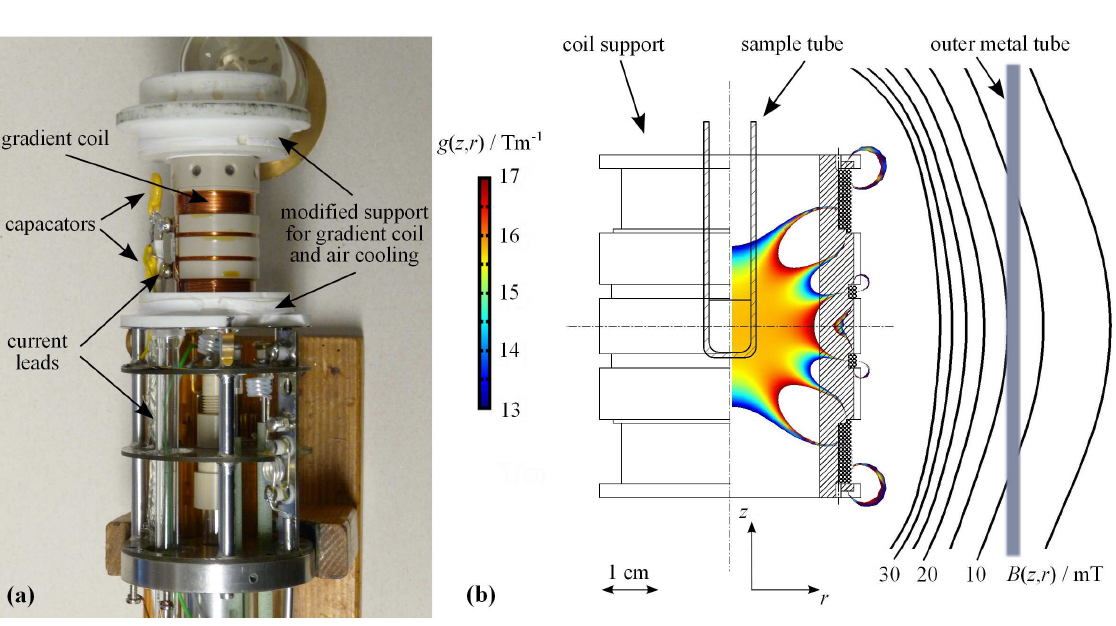
Figure 1. X-observe NMR probe equipped with a z -gradient coil. ( a ) Photograph of the top part of the NMR probe with its metal cover removed. Added and modified components are indicated; ( b ) Drawing of the gradient coil support with the color plot of the calculated field gradient g ( z, r ) at the NMR sample position and the contour plot of the stray field B ( z, r ) of the gradient coil at the position of the metal tube (outer probe cover). The spatial dependence of the gradient and field values are plotted for the maximum available gradient current of 100 A